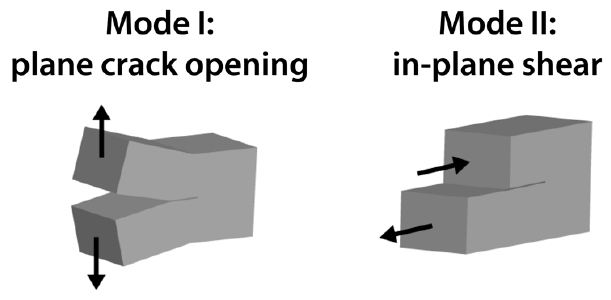
Figure 1. Di ff erent loading modes of fracture Figure 1. Different loading modes of fracture mechanics.